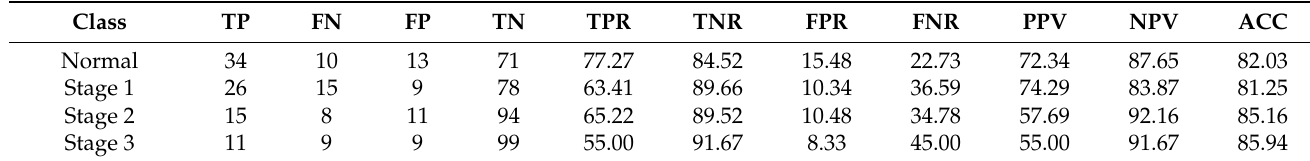
Table 7. Fluorosis classification accuracy on 128 blind test images.